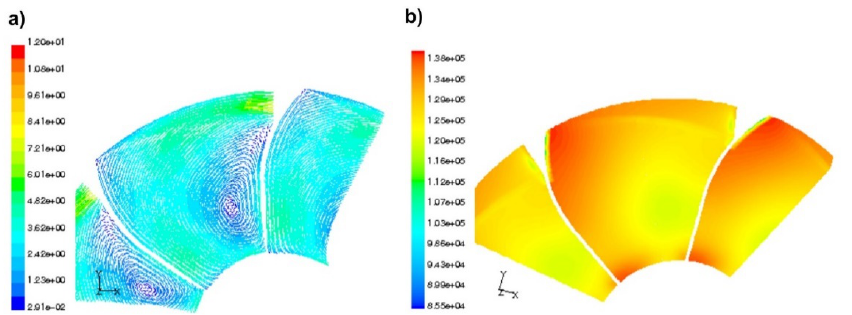
Figure 22. The field of: ( a ) velocity [m/s]; ( b ) static pressure [Pa] in the channels of the guide vanes for the variant of a 3 / b 3 = 1.25.